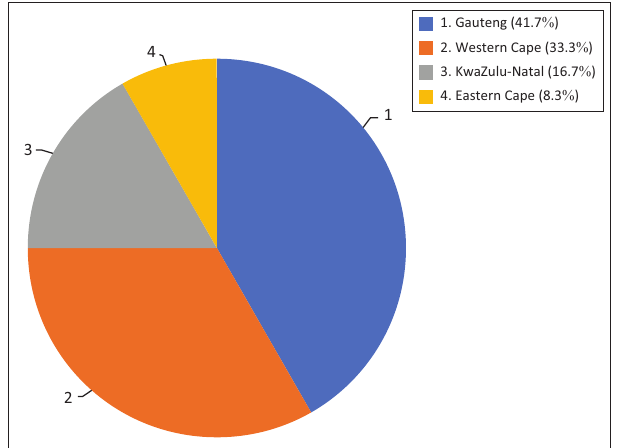
FIGURE 1: Number of participants per province.